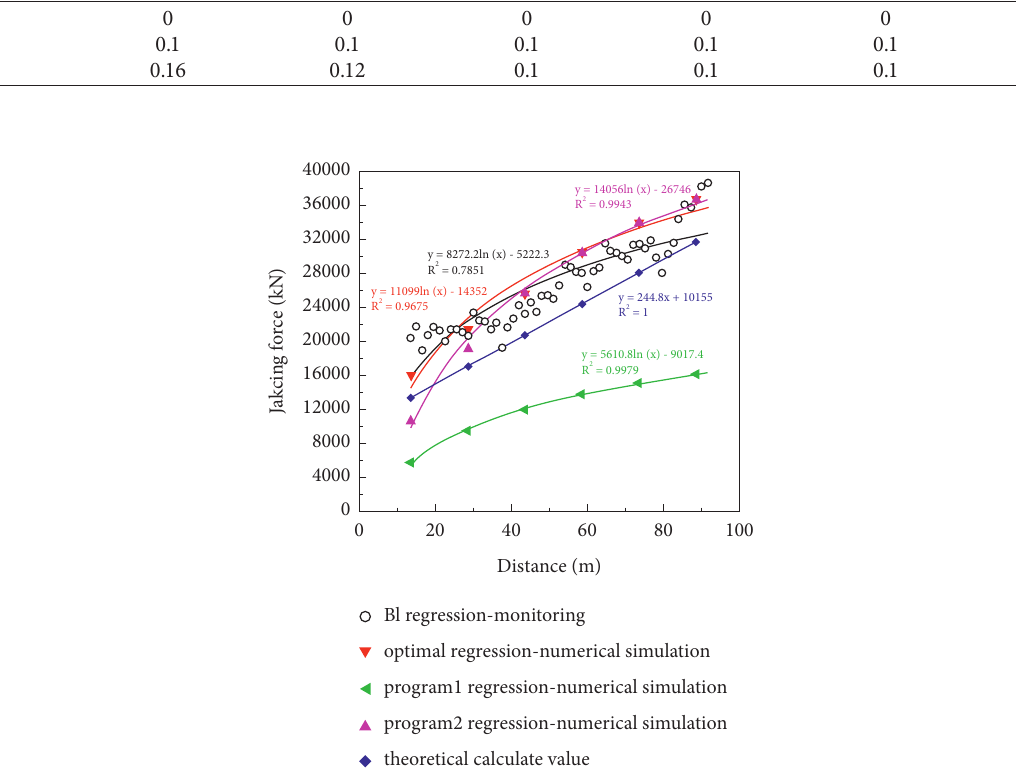
Figure 10: The comparison of jacking forces from monitoring, the empirical equations, and the displacement control method for case B1 (program 1, program 2, and program 3